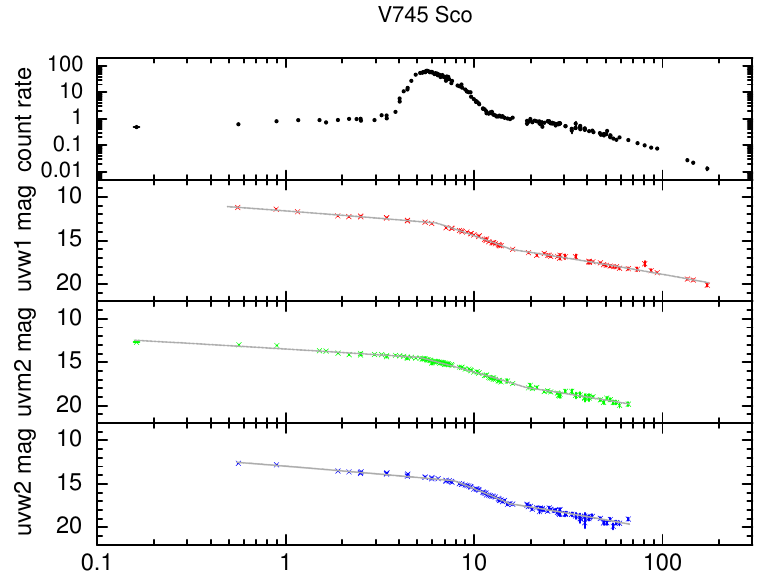
Figure 8. The XRT and UVOT light-curves of V745 Sco, with the best-fit broken power-law declines shown as the grey solid lines. The X-ray data (top) are in count s − 1 over 0.3–10